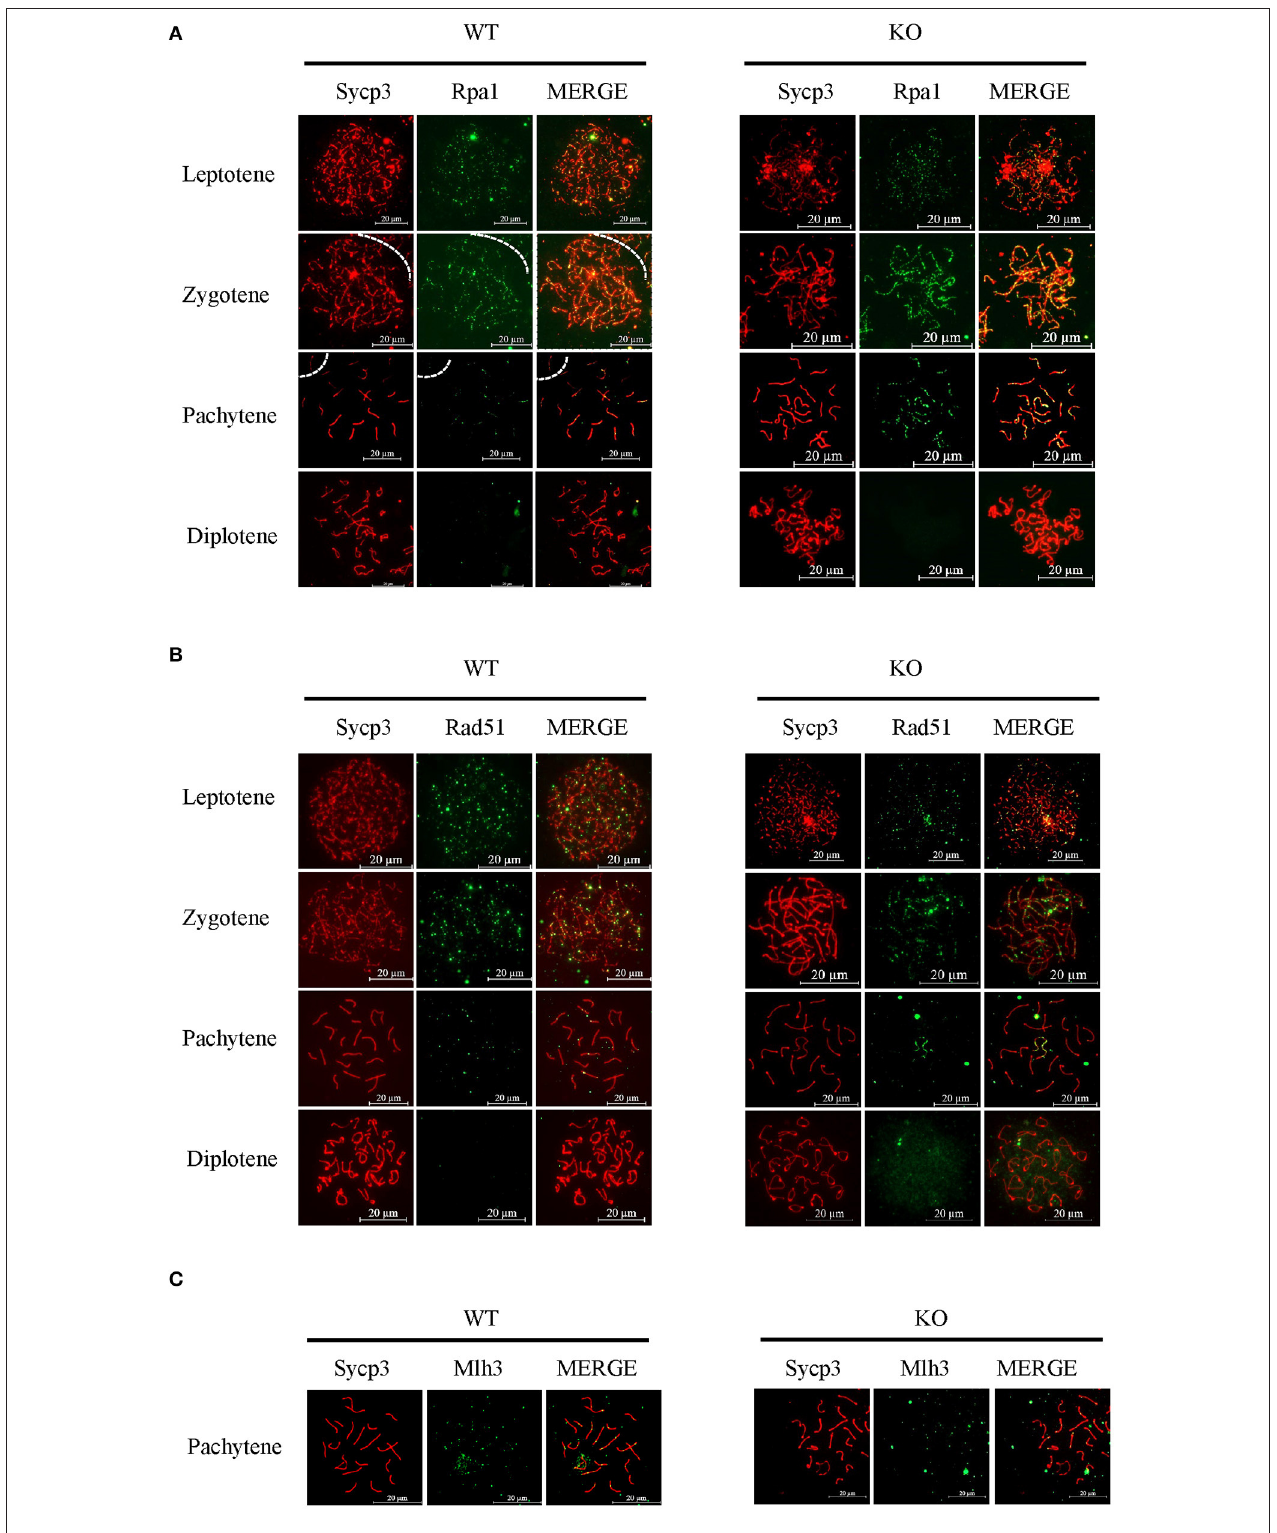
FIGURE 7 | Sugp2 is not essential for meiotic recombination. Immunolabeling for the synaptonemal complex component Sycp3 and recombination protein Rpa1 (A) and Rad51 (B) . (C) The crossover formation was analyzed by staining Mlh3. Scale bar = 20 µ m.